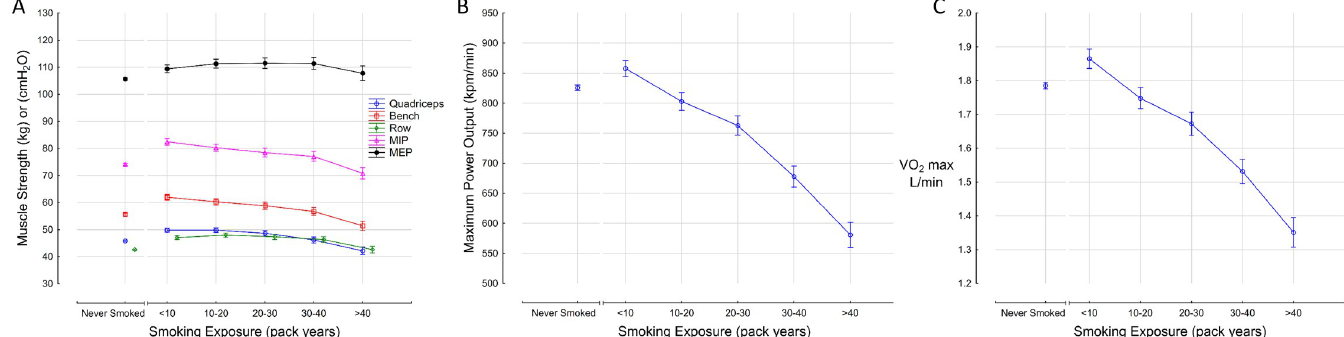
Fig 4. Effect of cigarette smoke exposure on muscle strength (A), maximum power output (B), and VO2 max (C). MEP; maximum expiratory pressure, MIP; maximum inspiratory pressure.